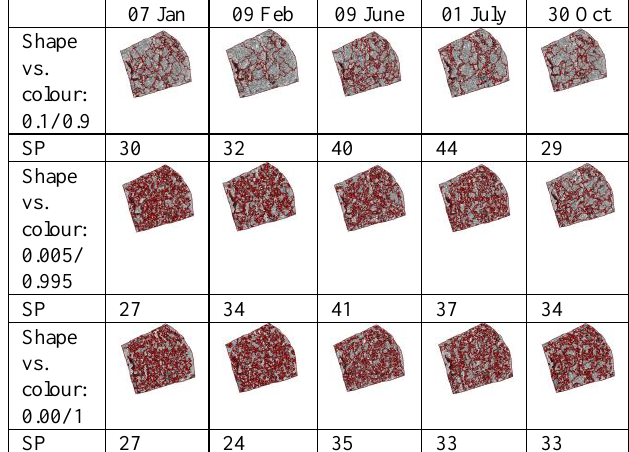
different weighting of shape vs. colour criteria. Three combinations of shape vs. colour were tested on all TS-X images (Table 2).